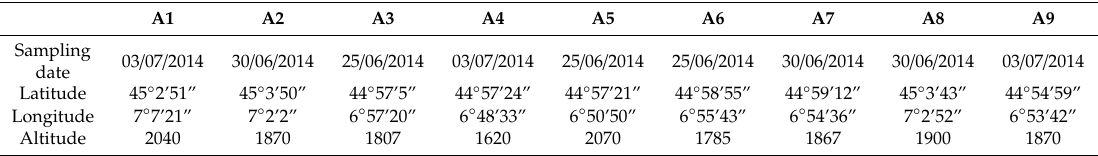
Table 1. Sampling date and geolocation of the investigated pastures (A1–A9) during the 2014 summer